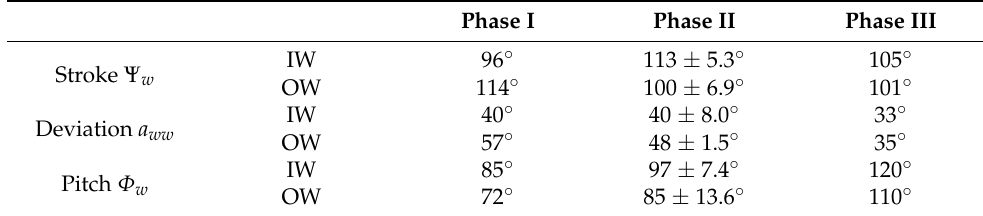
Figure 5. Wingbeat kinematics variables of stroke ( Ψ w ), deviation ( θ w ), angle of incidence ( Φ w ), θ twist at 0.25 R, 0.50 R, and 0.75 R, and wing tip velocity ( U tip ) during the entire maneuvering motion. DS is indicated by grey shading and US is indicated by white shading. IW is indicated by red curves and OW is indicated by blue curves. R represents span length. Table 2. Comparison of angular wing kinematics